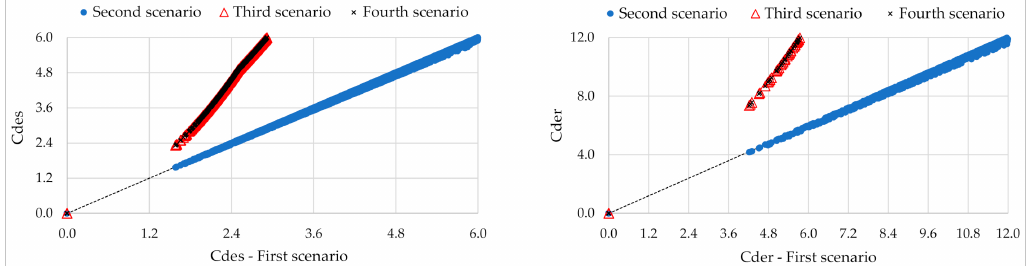
Figure 12. Safety coefficients for the first scenario compared with the second to fourth